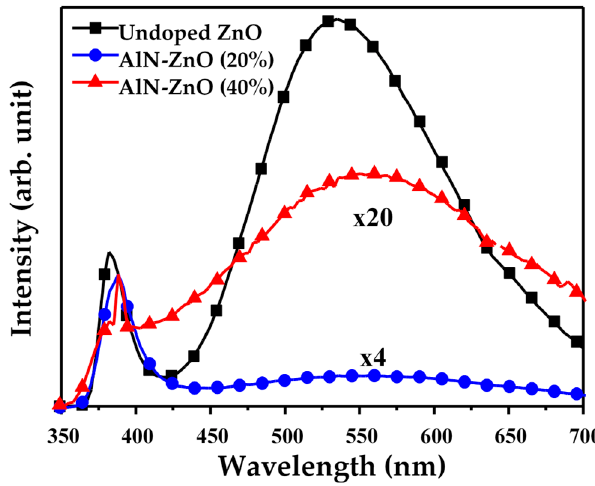
Figure 3. Room temperature PL spectra of the undoped and cosputtered AlN-ZnO films with Al atomic ratios of 20% and 40%, respectively, annealed at 700 °C for 30 min under vacuum ambient.